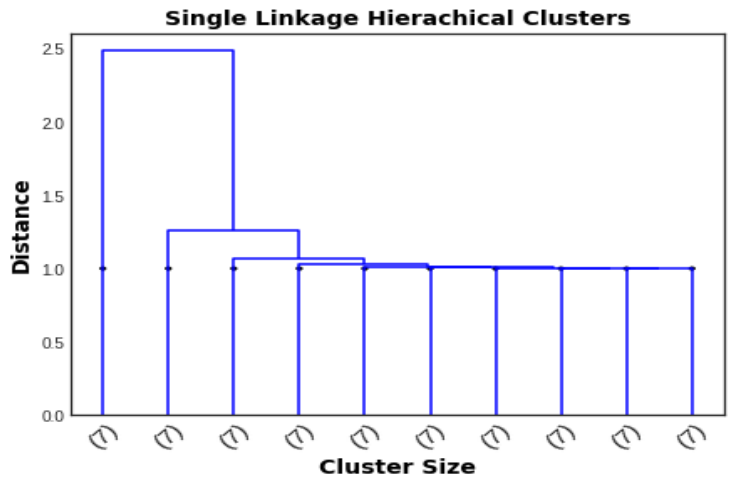
Figure 4. Hierarchical clustering using the single linkage clustering technique.